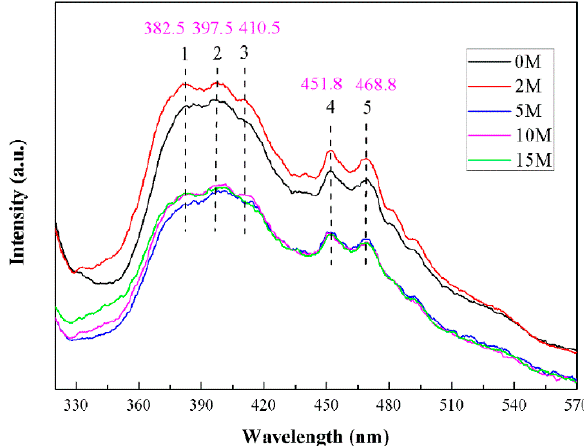
Figure 7. Photoluminescence (PL) emission spectra of as-prepared samples.